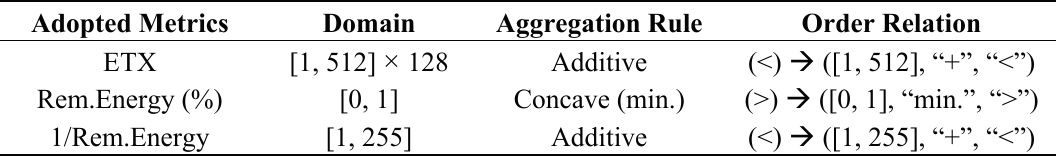
Table 3. Descriptions of the ETX, RE and derived RE routing